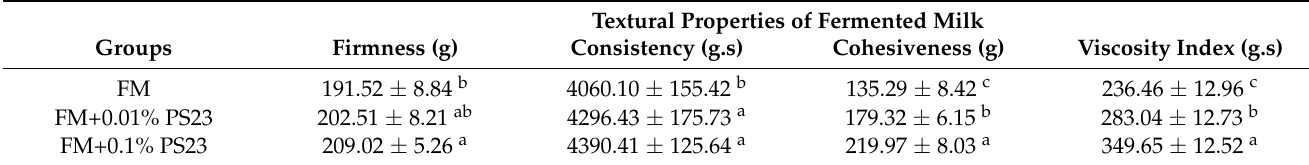
Table 1. Textural properties of fermented milk samples with